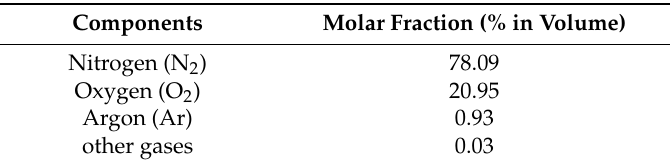
Table 5. Chemical composition of dry air.